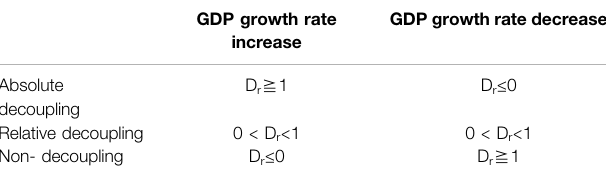
TABLE 3 | The values of D r in the different decoupling